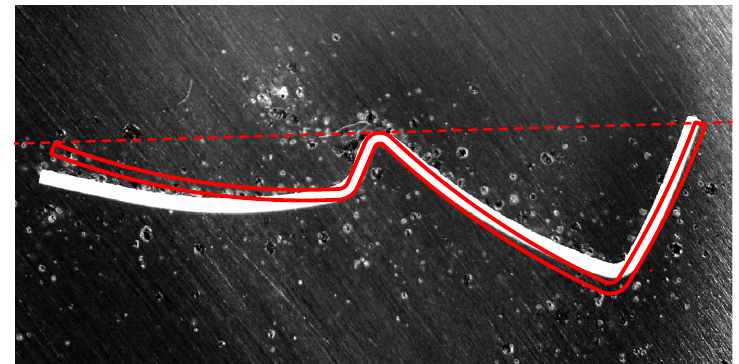
Figure 2. Cross-section of a production sample of the slats provided by the manufacturer with an overlay showing the design geometry. Note that the endpoints and the apex in the middle of the profile are collinear in the design but not so in the de-facto section. Also note that the curvature of the profiles slightly diverge (Source: H.